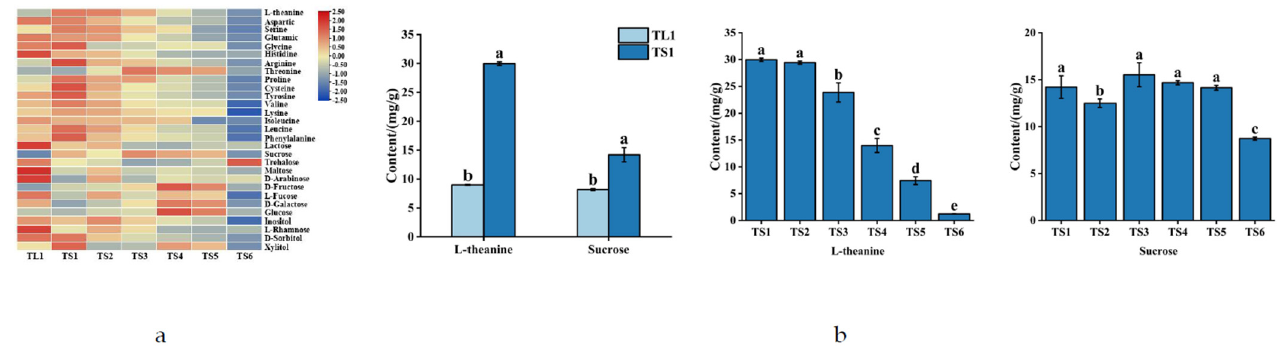
Figure 5. Primary phytochemical composition of tea stems with different degrees of tenderness. Different superscript letters denote significant differences ( p < 0.05).